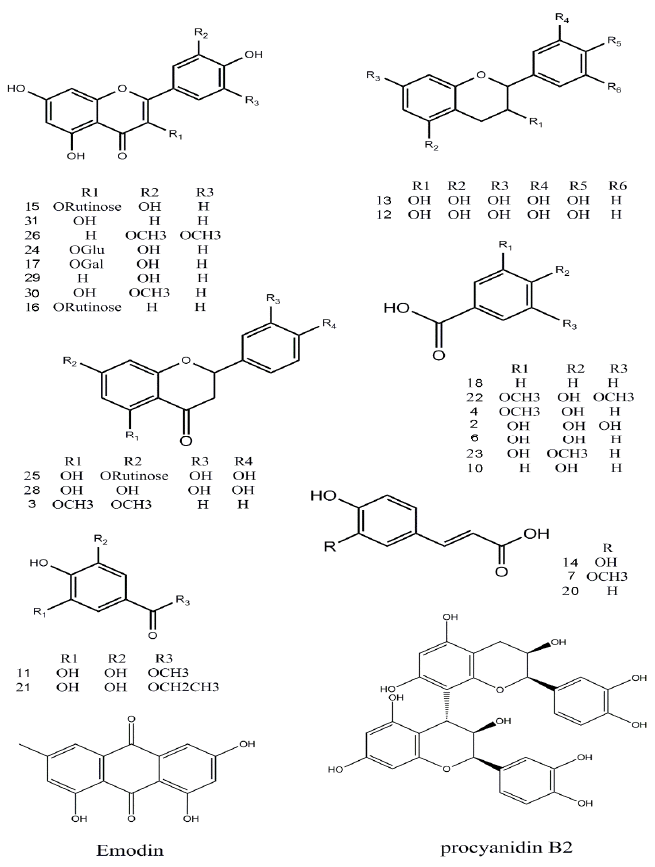
Figure 4. Chemical structures of the main identified compounds in the EA extract from F. dibotrys .